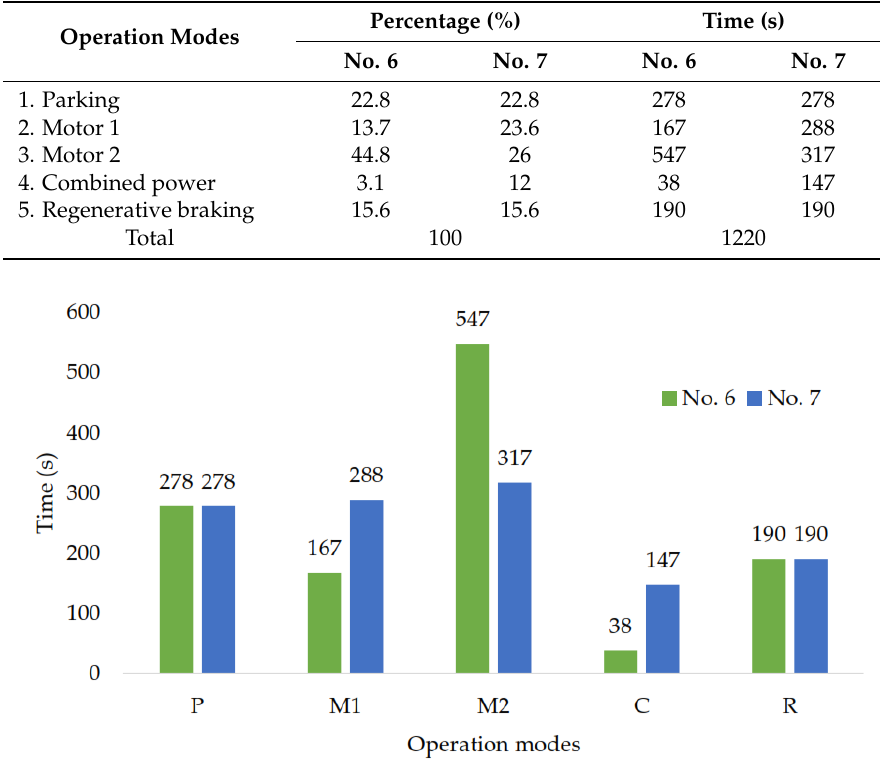
Figure 16. The comparison of operation mode selection between No. 6 and No. 7.